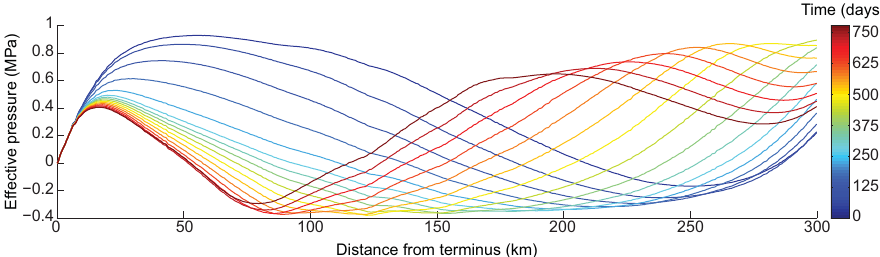
Figure 2. Effective pressure plotted for the ice stream in 50-day intervals, illustrating downstream movement of pressure waves. The outputs range from year 81 to